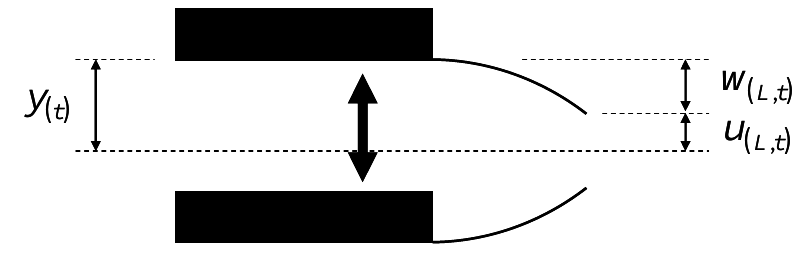
Figure 1 . Cantilever movement in acoustic excitation. u w is the relative tip motion to the base motion y (x,t)